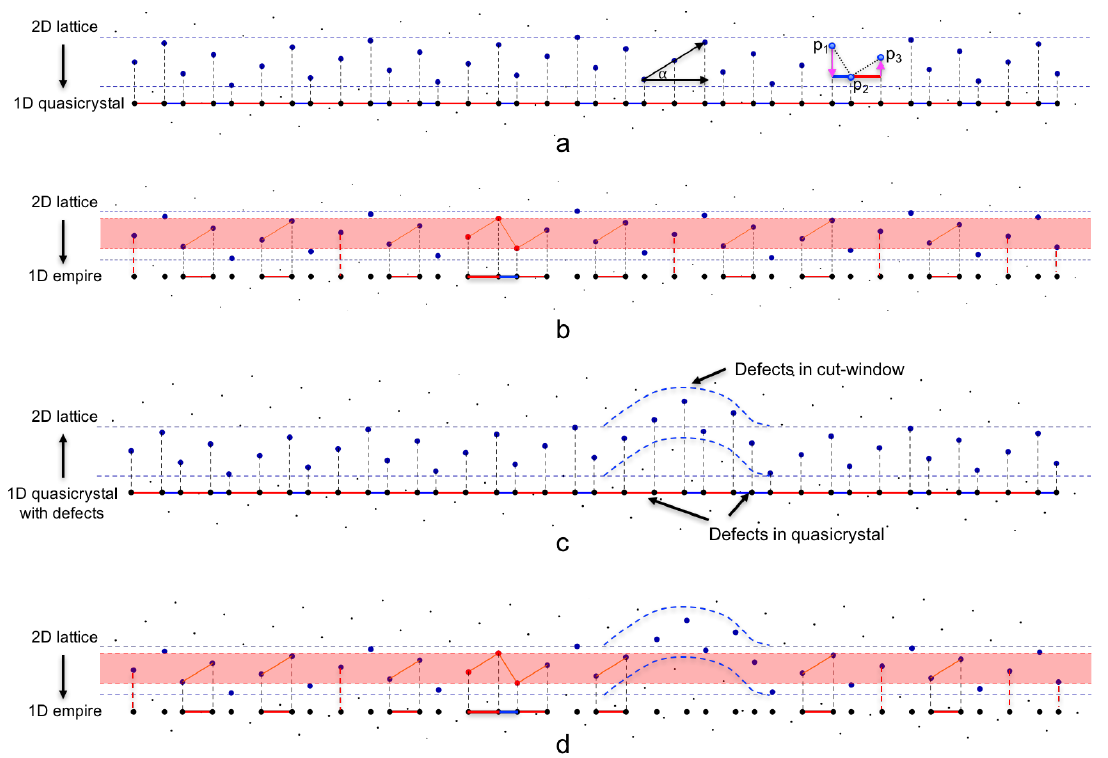
Figure 15. ( a ) Illustration of the cut-and-project method for obtaining a one dimensional quasicrystal, the Fibonacci word, from the Z 2 lattice; ( b ) illustration of the cut-and-project method for obtaining the empires in the Fibonacci word; ( c ) illustration of the reversing cut-and-project process, from a defected Fibonacci word to corresponding points in the two dimensional Z 2 lattice; ( d ) illustration of the cut-and-project method for obtaining the empires in the defected Fibonacci